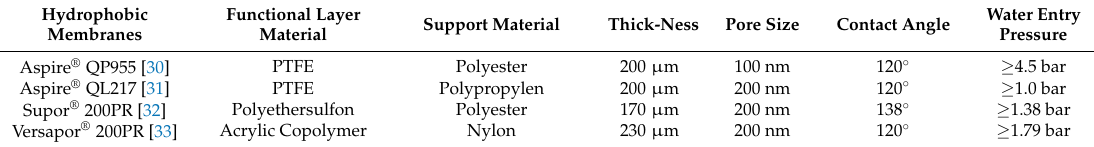
Table 2. Data summary of the polymer based porous hydrophobic membranes. Data extracted from the data sheet provided by Clarcor Air for Aspire ® QP955 and Aspire ® QL217 and by Pall for Supor ® 200PR and Versapor ® . Contact angle of water determined by contact angle measurements at lab conditions against air with a measuring accuracy of ±2.5°.